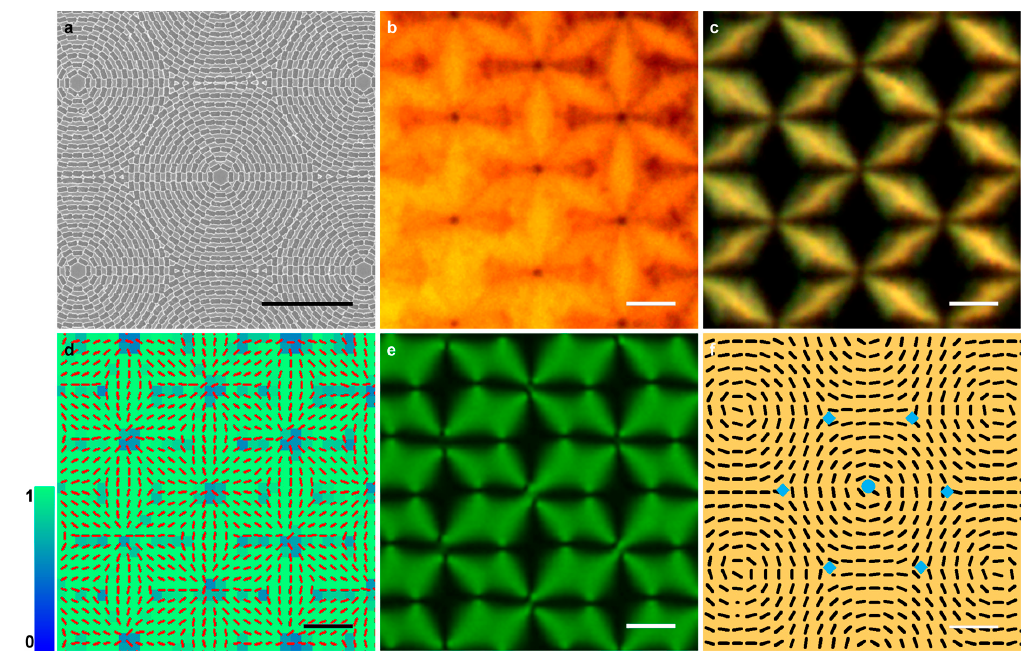
Figure 3. Exemplary PMM based on rectangular nanoapertures. ( a ) SEM picture of a PMM; ( b ) Bright-field microscopy image of the PMM; ( c ) Cross-polarized microscopy image of the PMM; ( d ) Spatial polarization state of the light transmitted through the PMM. The scale bar on the left hand side indicates the optical transmission; ( e ) A polarizing microscopy texture of a nematic LC cell patterned with the PMM; ( f ) Measured director field of the nematic LC, blue circle and diamonds correspond to the centers of +1 and − 1/2 topological defects, respectively. The scale bars are 2.5 μ m in ( a – d ) and 25 μ m in ( e , f ).